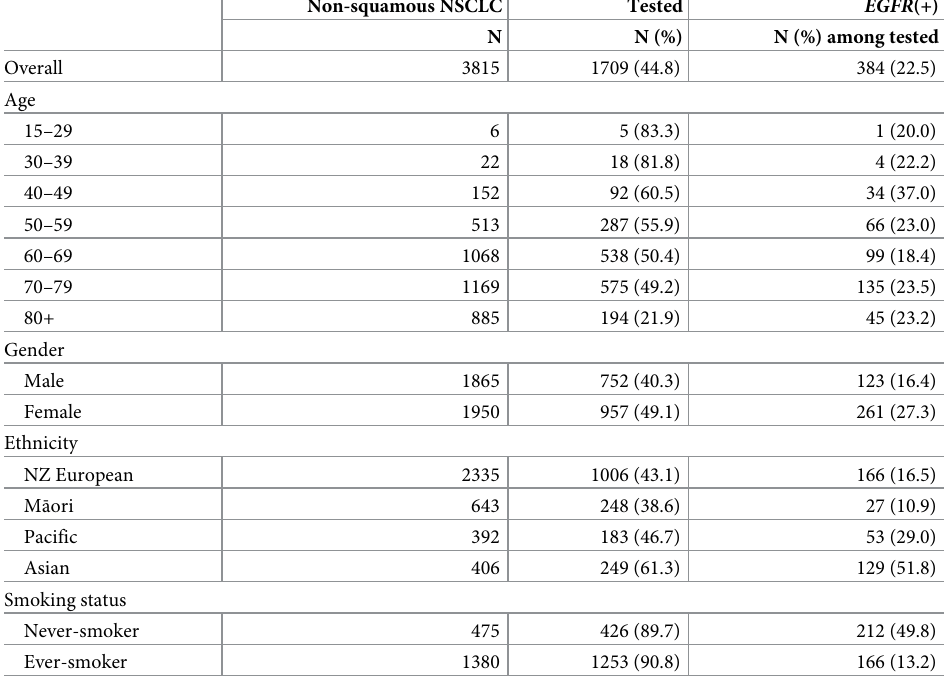
Table 1. Numbers of non-squamous NSCLC patients, patients tested for EGFR mutations, and EGFR mutation- positive patients shown by age, gender, ethnicity and smoking status in northern New Zealand, between 1 Febru- ary 2010 and 31 July